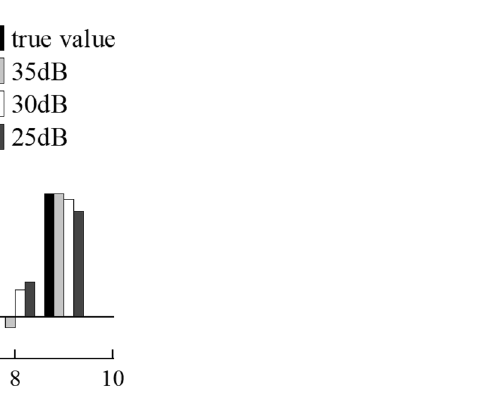
Figure 11. Identification results of moving force on Class-A road surface in multi-damage case under ( a ) 35 dB, ( b ) 30 dB and ( c ) 25 dB.